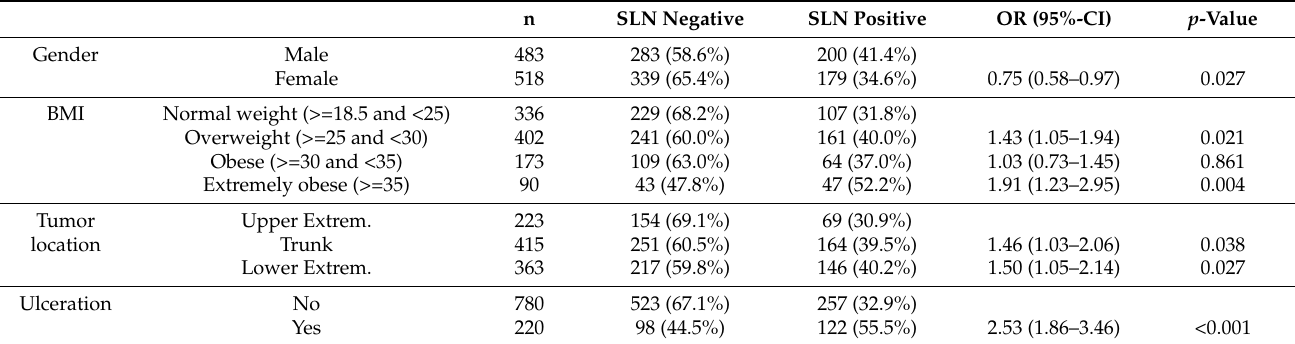
Table 6. Metastases in the sentinel lymph node biopsy-categorical